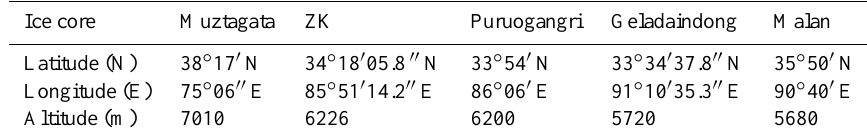
Table 2. Basic information of ice cores from the northern TP. Ice